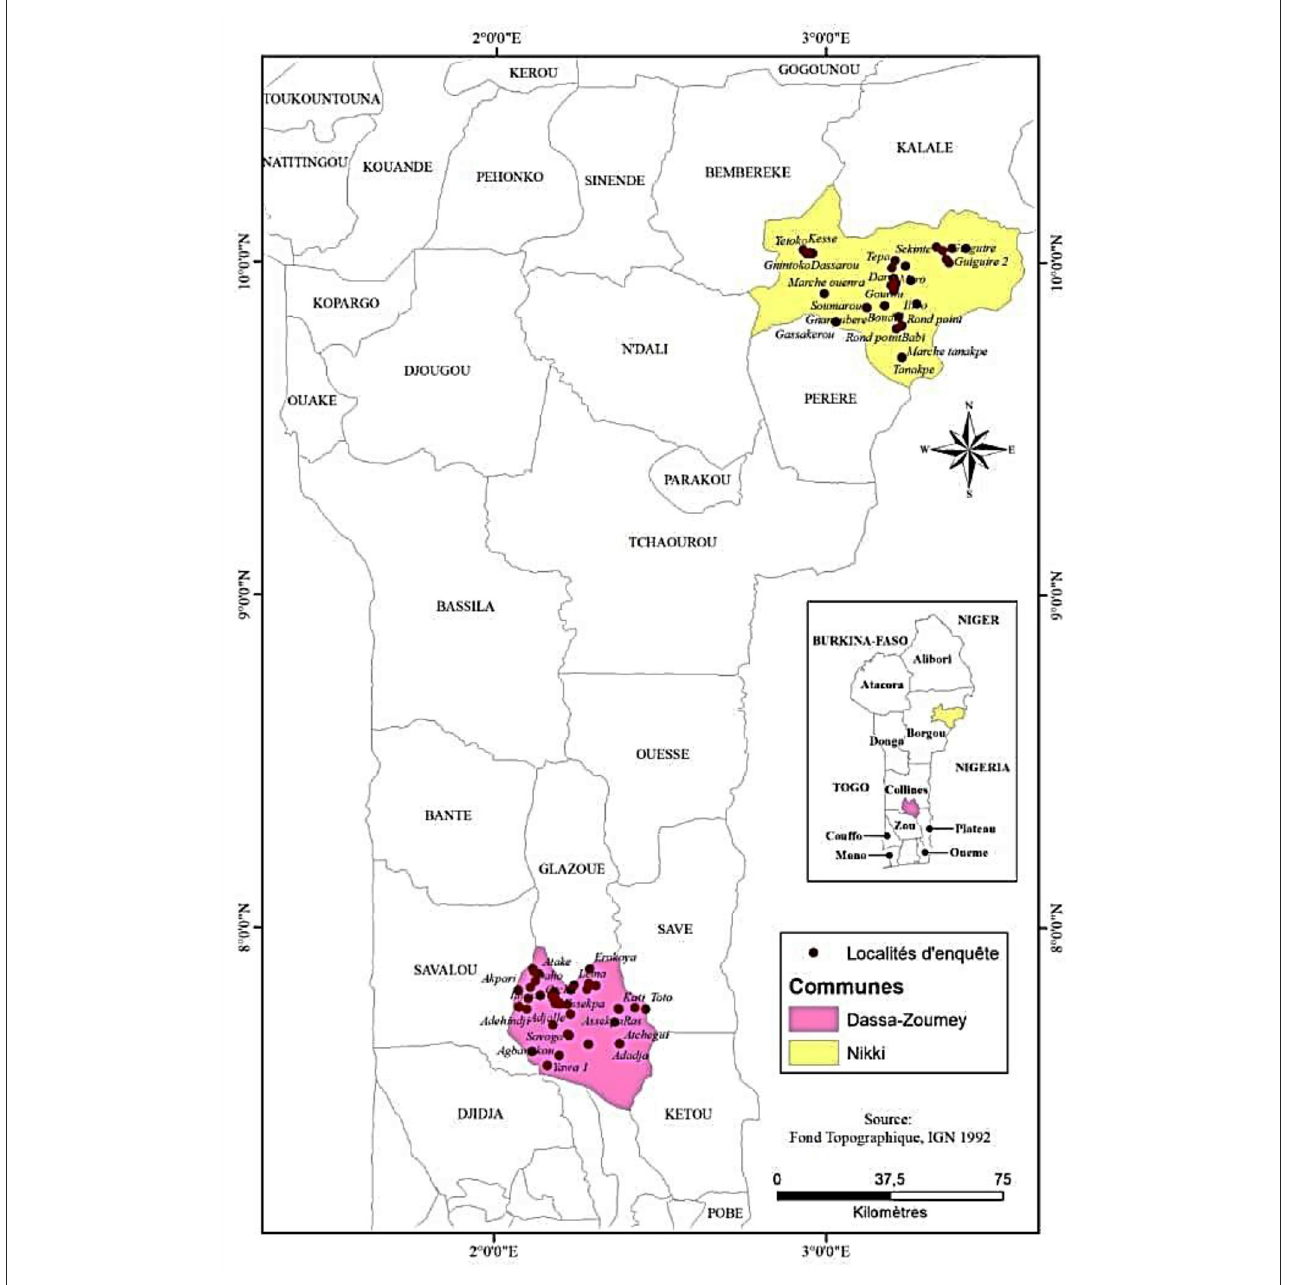
FIGURE1 Map of the two study areas: Nikki in northern Benin and Dassa-Zoumé in central